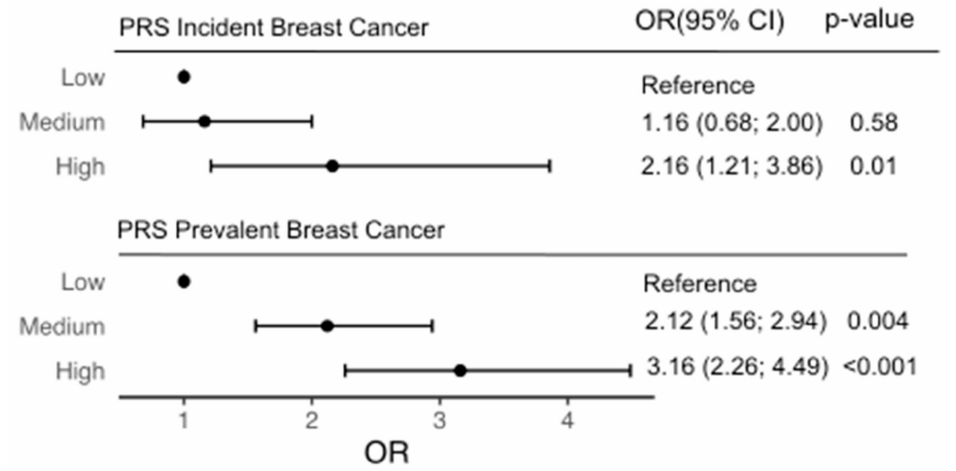
Figure 1. Association of a polygenic risk score (PRS) with incident and prevalent breast cancer (BC) risk in 6339 older women. We evaluated incident BC diagnoses over a median follow-up of 4.7 years and prevalent BC diagnosed pre-enrolment (self-reported). A multivariable Cox regression model including conventional risk factors examined the association between incident BC risk and the PRS as a categorical variable by quintiles (Q) of the distribution (low- (Q1), medium- (Q2–4), high- (Q5) risk groups), adjusting for family history of BC (first-degree blood relatives), treatment (aspirin/placebo), age at enrolment, number of children, alcohol consumption, body mass index (BMI) at enrolment, and use of estrogen or estrogen/progesterone hormone replacement therapy (HRT) at enrolment. Logistic regression examined associations with prevalent BC, adjusting for family history of BC (first-degree blood relatives) and pathogenic variants in BC-associated genes, represented by odds ratio